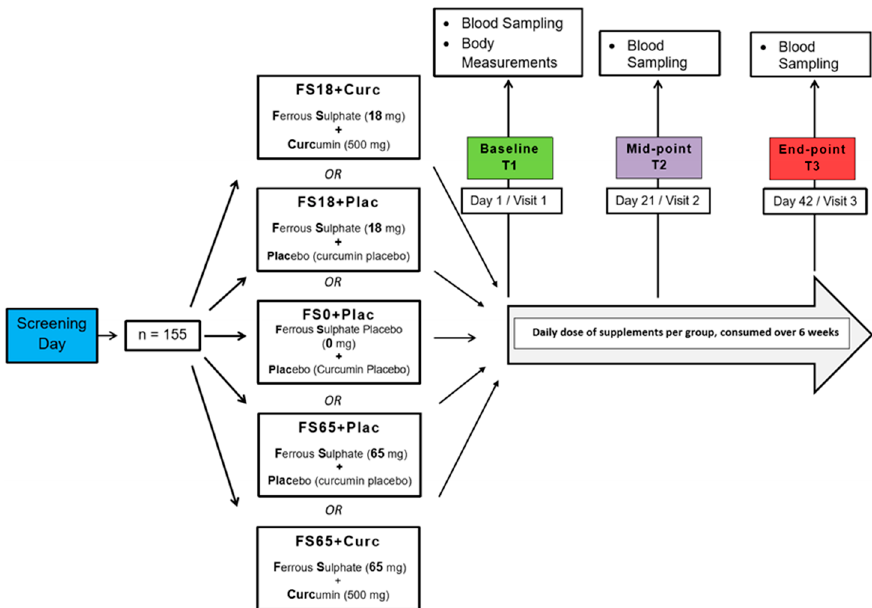
Figure 1. Study design. Participants who met the inclusion criteria during the screening day were randomly assigned to 5 different treatment groups ( n = 31/group). There were three visit days over the study duration of 6 weeks. On the first visit day, (Baseline) body measurements, blood samples and questionnaires were collected from the participants. On the following visit days, (Mid-point and End-point) blood samples and questionnaires were collected from the